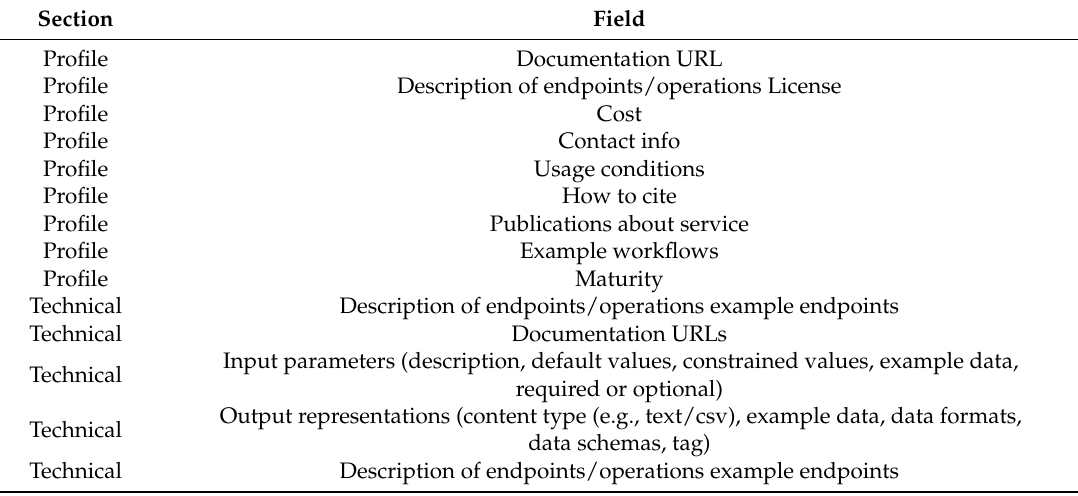
Table 1. Biodiversity Catalogue Service